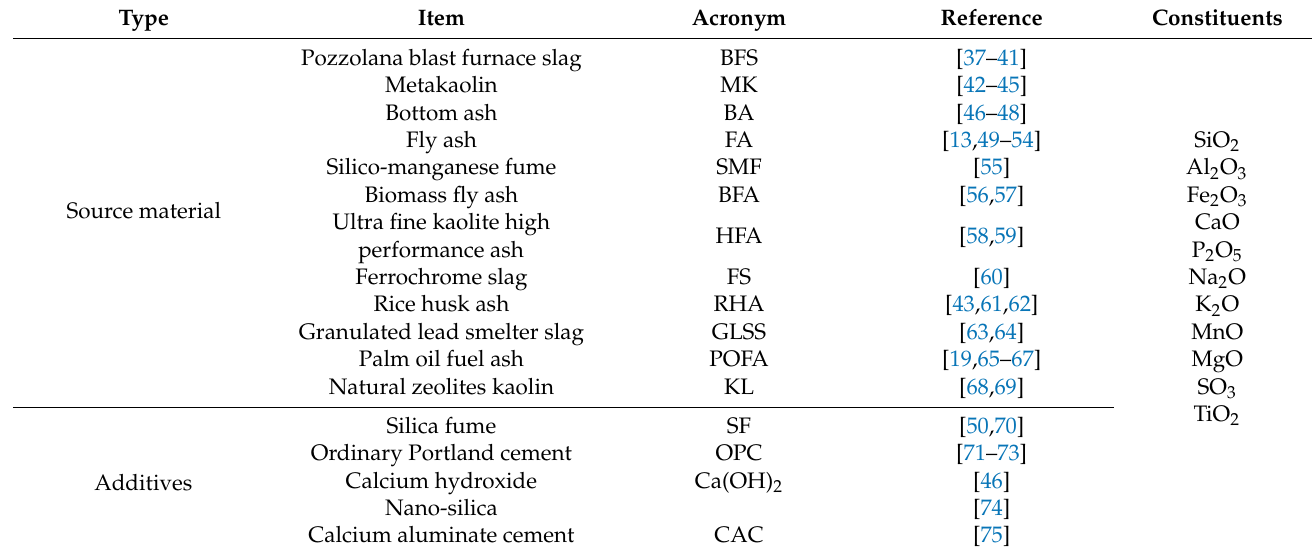
Table 1. Major source materials of